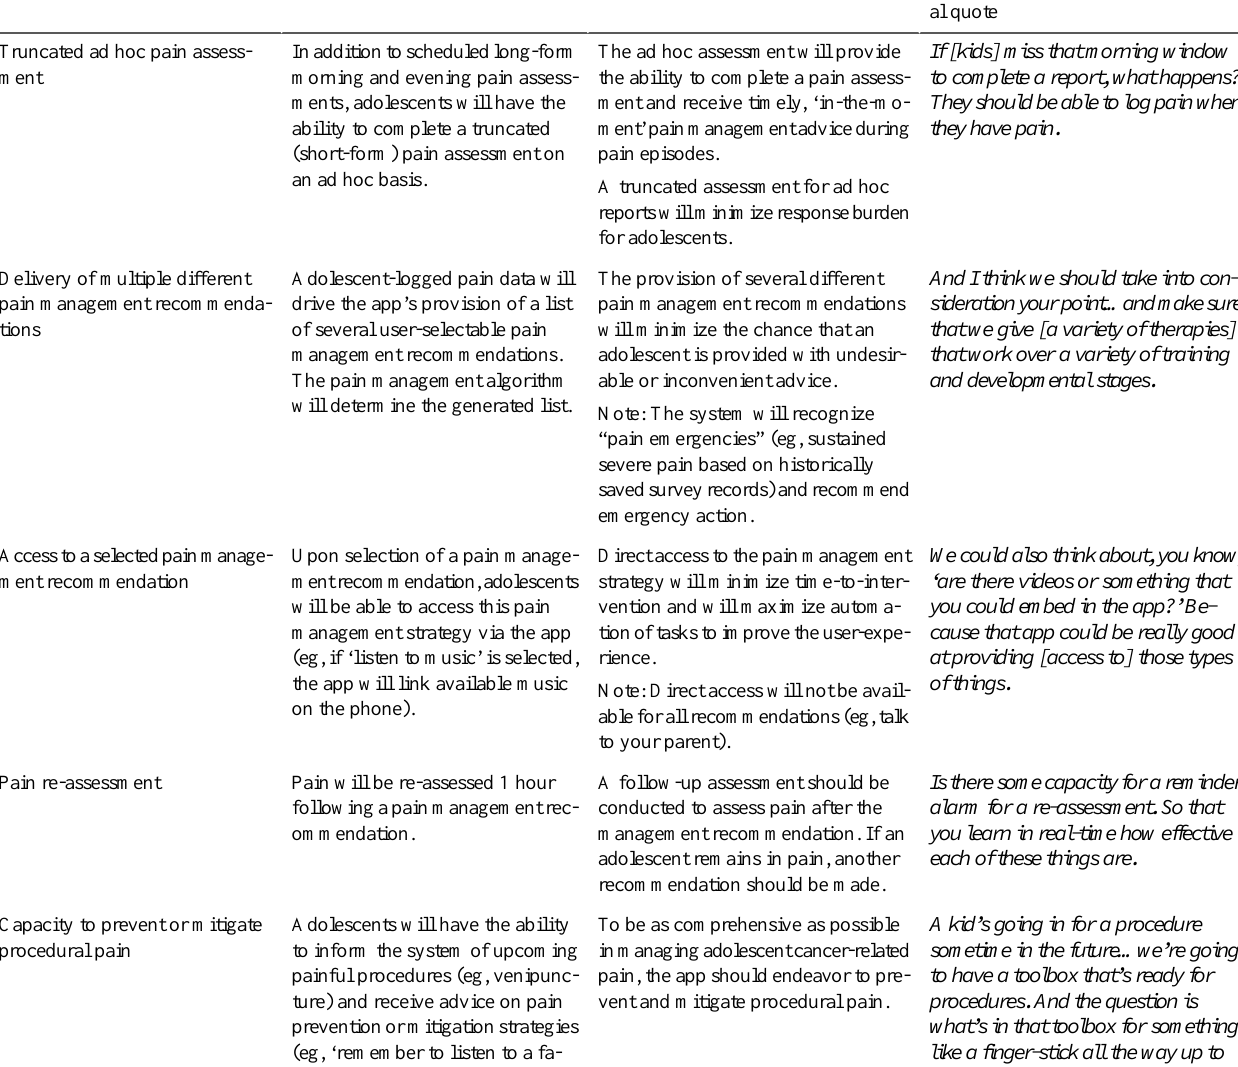
Table 3. Requirements of the smartphone-based pain management app based on expert